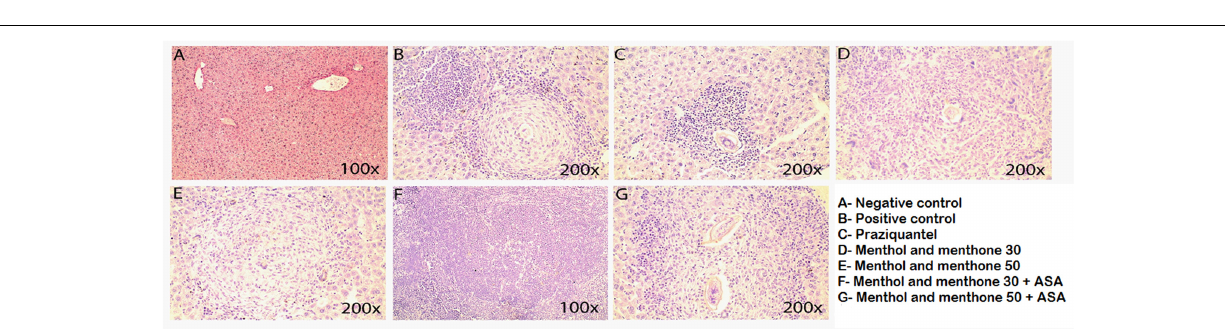
FIGURE 2 | Liver histology stained with HE. Negative control (A) , positive control (B) , praziquantel (C) , menthol and menthone 30 (D) , menthol and menthone 50 (E) , menthol and menthone 30 + ASA (F) and menthol and menthone 50 + ASA (G). Coloration hematoxylin-eosin (H.E) increase: 100 × /color H.E. Increase: 200 × ; except (A,F) with 100 ×